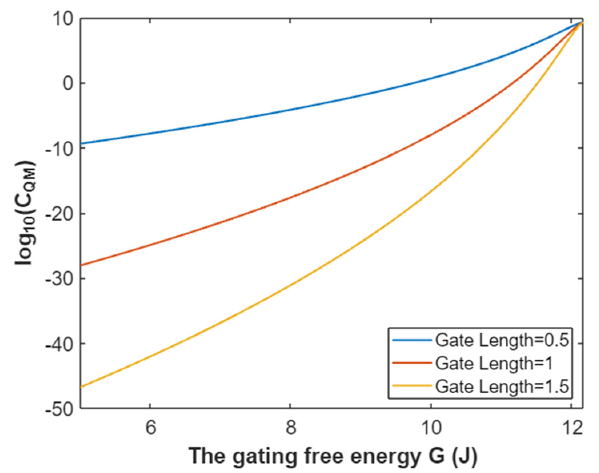
Based on Equation (39), the mathematical representation of the relationship between gating free energy and the common logarithm of quantum membrane conductance of intracellular sodium ions is plotted as in Figure 16.